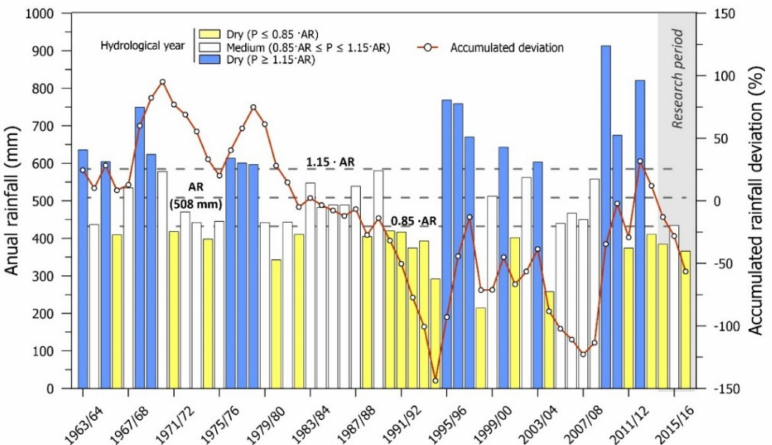
Figure 2. Evolution of annual rainfall and its accumulated deviation in the Jarales area (recording period 1963/64 to 2016/2017). Modified from Gil-M á rquez [35]. References to wet, intermediate, and dry hydrological years are